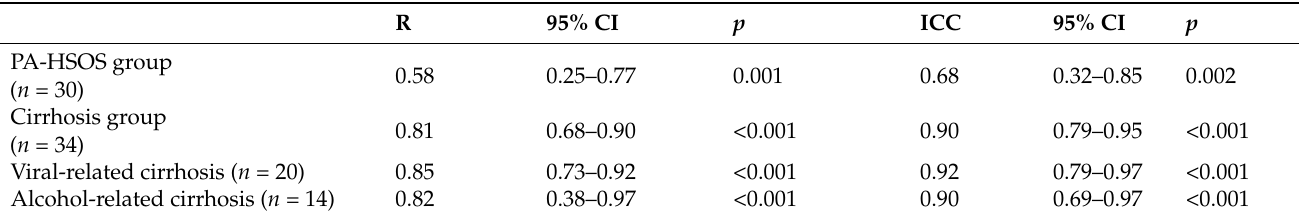
Table 2. Correlation between WHVP and PP.